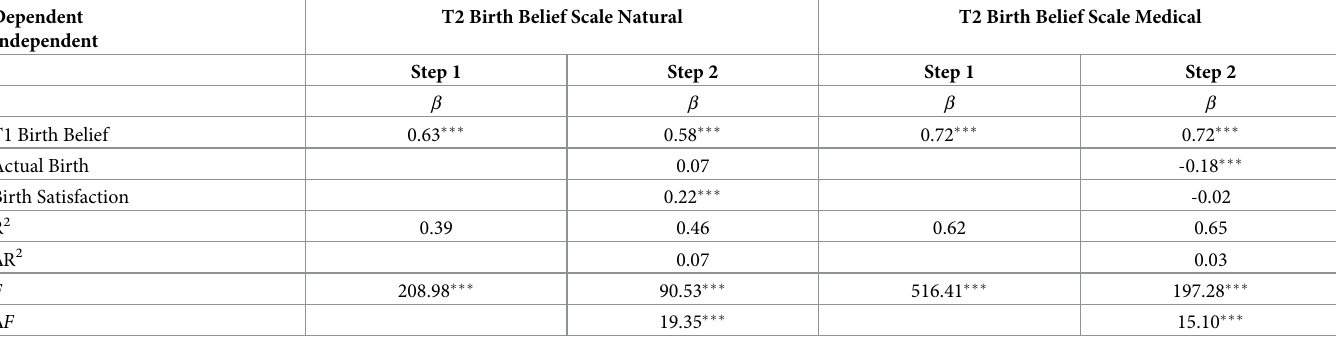
Table 4. Linear regression models predicting prenatal to postpartum changes in basic birth beliefs ( n = 322). Dependent